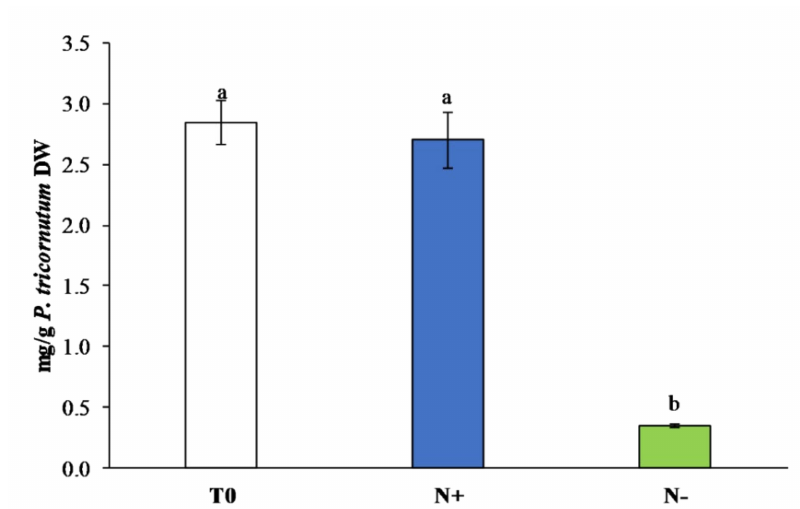
Figure 6. Carotenoid content (mg/g DW) in P. tricornutum extracts cultivated for 15 days under initial culture conditions (T0, white bar), under standard conditions (N+, blue bar), and under starvation conditions (N − , green bar). Values are reported as the means ( n = 3), and error bars report the standard deviations. Treatments that do not share the same letter were significantly different from each other ( p < 0.05).